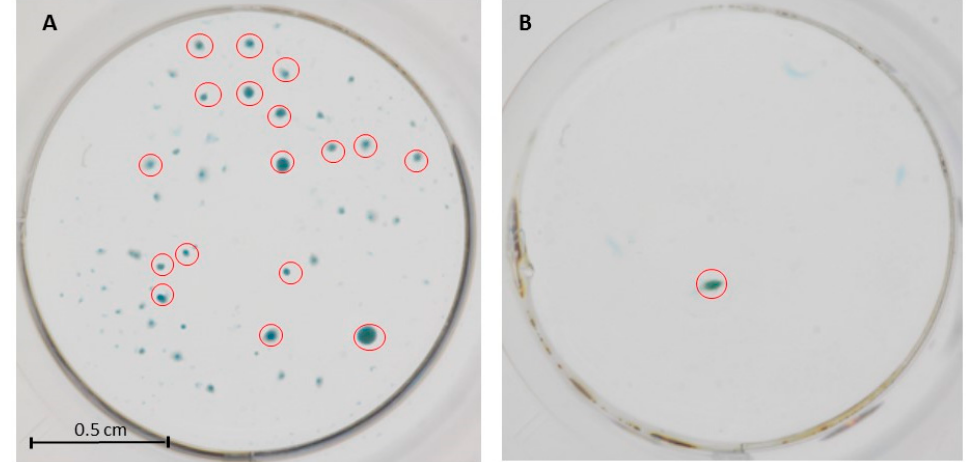
Figure 1. Macroscopic aspect of chondrocytes micromass obtained from adipose-derived stem cells (ADSCs) derived microfat-PRP in the presence of chondrogenic differentiation media ( A ) or control media ( B ). Red circles represent micromass with area > 0.05 mm 2 .